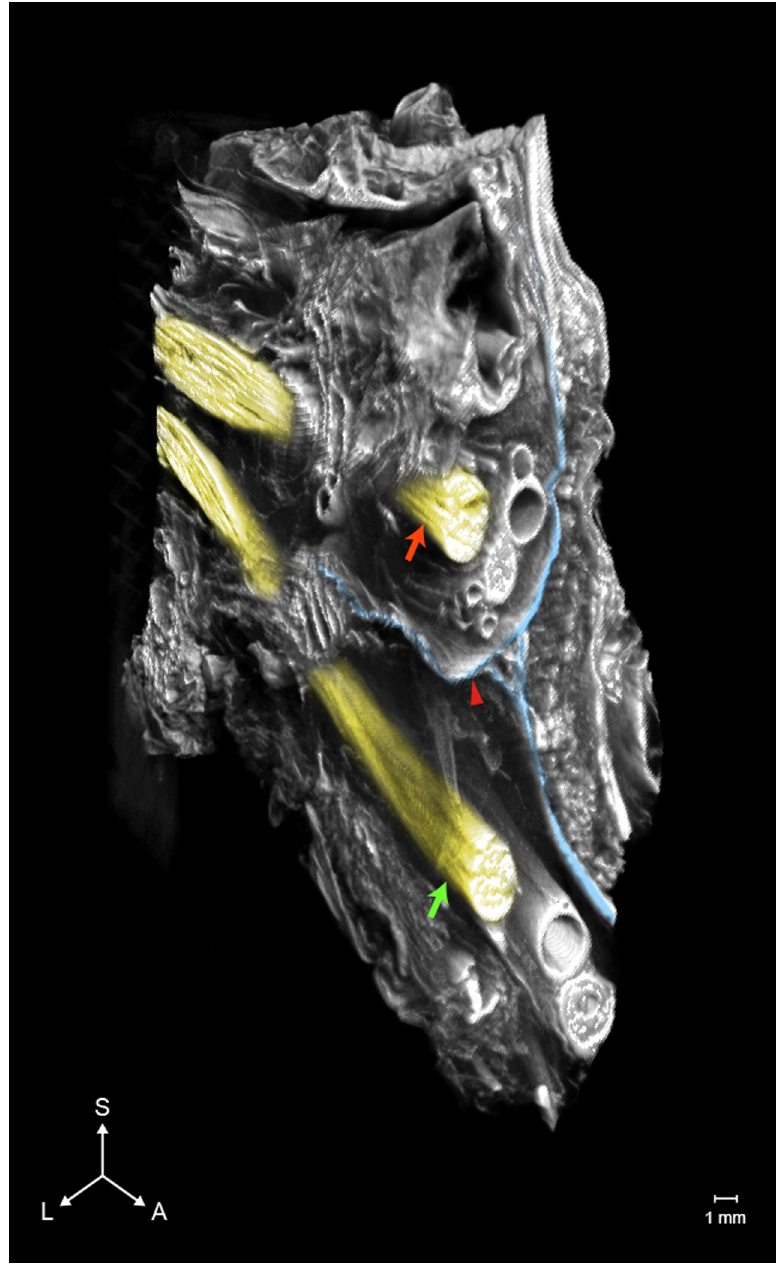
Fig 3. MicroCT images of the calcaneal tunnel. The interfascicular septum (IFS) separates the plantar nerves as the medial plantar nerve (MPN) and the lateral plantar nerve (LPN), which each innervate a space of the tunnel created by the IFS. Blue, IFS; Red arrow, MPN; Green arrow,